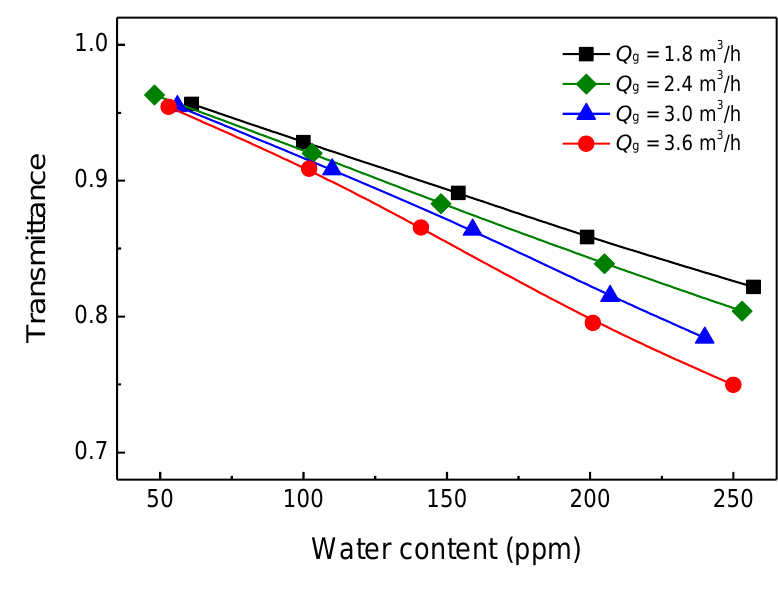
Figure 10. Transmittance characteristics in gasoline pipe